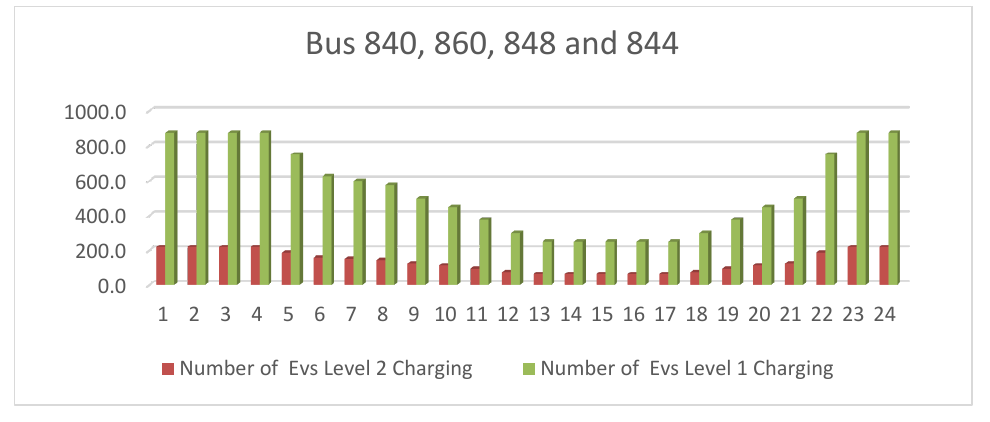
Figure 7 . Case 1 number of EVs on Bus 840, 860, 848 and 844.